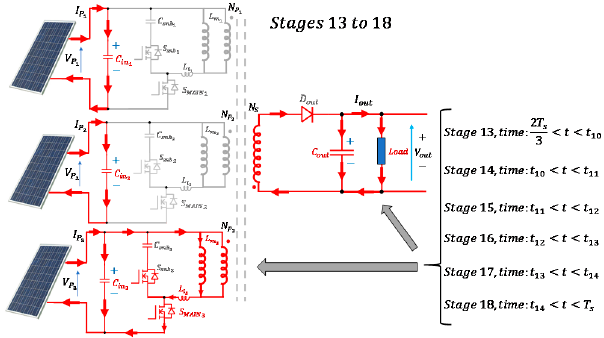
Figure 9. Schematic of stages 13 to 18, time: 2 T S /3 < t < T s .